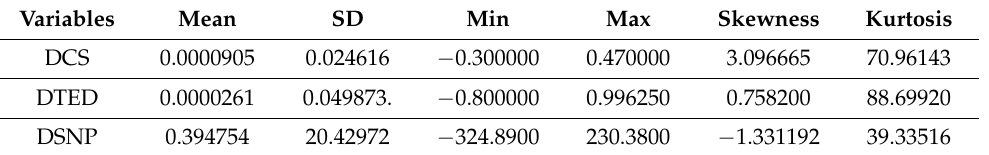
Table 12. Descriptive Statistics for Explanatory Variables.